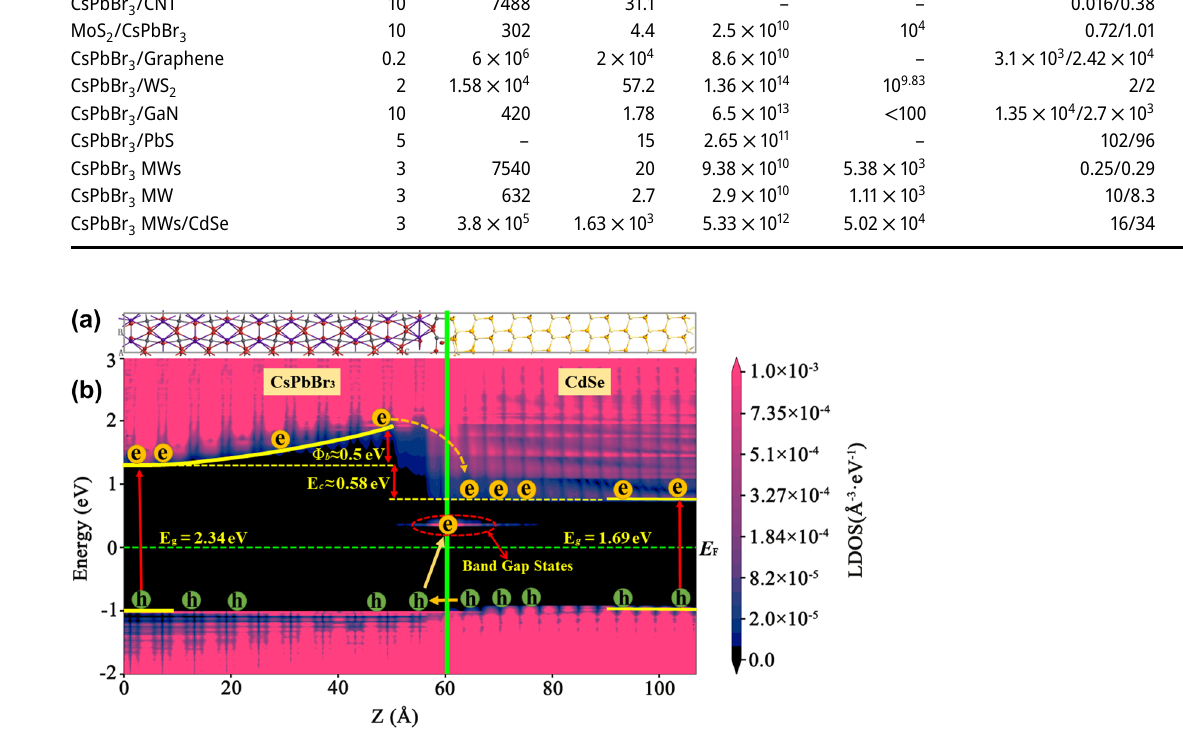
Figure 8: Crystal structure and band arrangement of CsPbBr heterostructure. (b) Band diagram showing the spatial resolved PLDOS across the CsPbBr